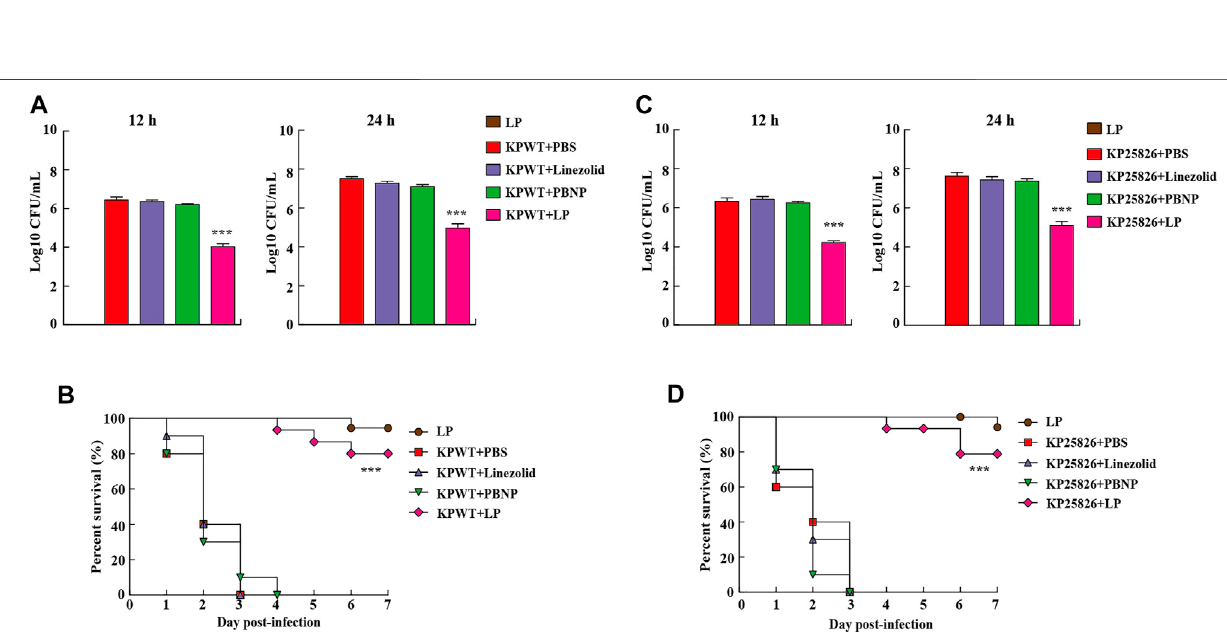
Frontiers in Pharmacology |